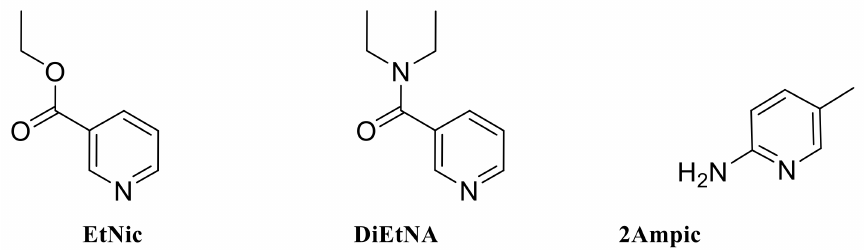
Figure 1. Structures of the studied ligands EtNic [64–66], DiEtNA [67–70] and 2Ampic